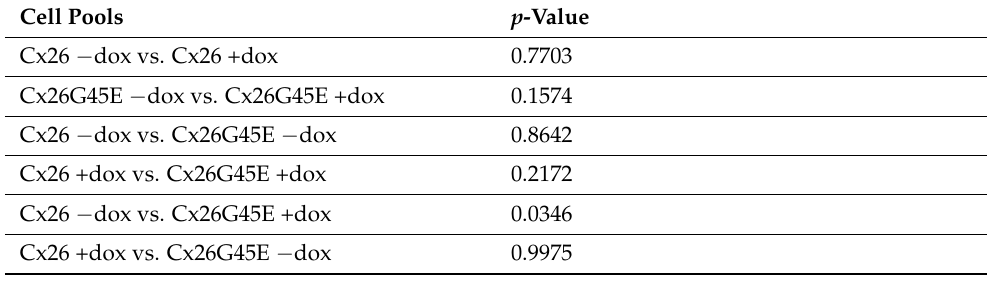
Table 3. Statistical comparisons for results presented in Table 2 calculated with the Bonferroni post hoc test for pairwise comparisons after the ANOVA test.